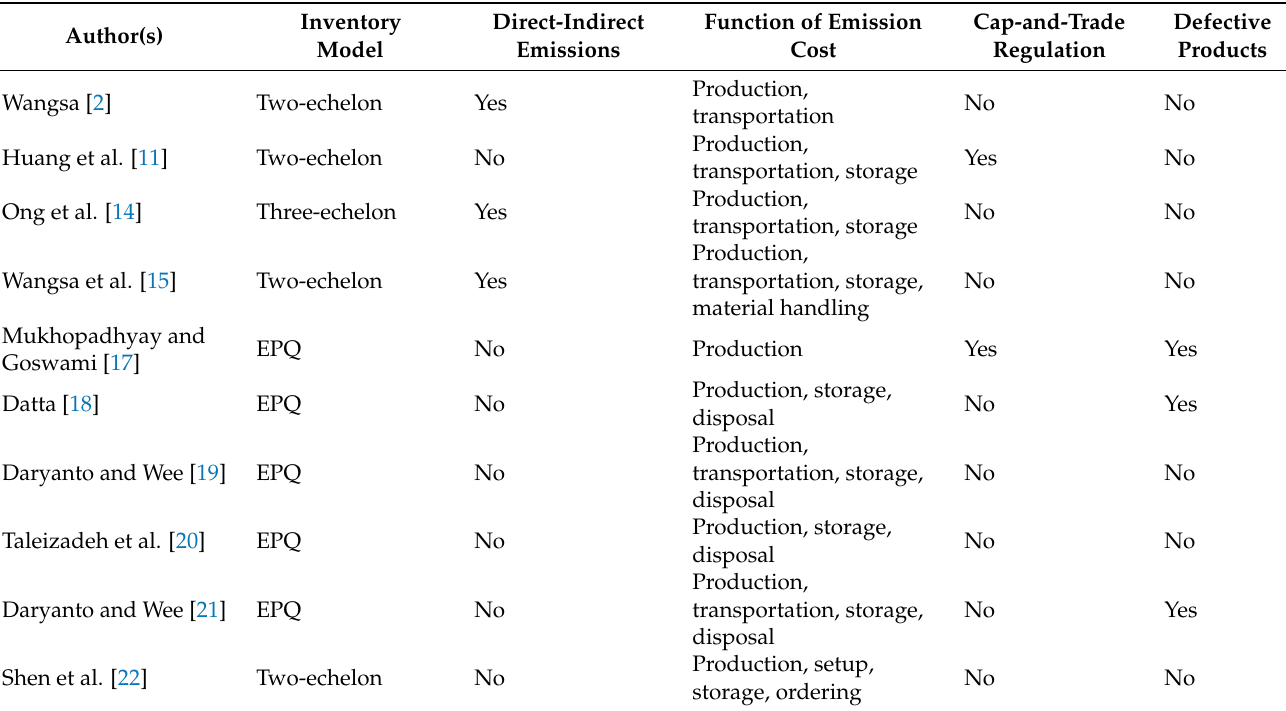
Table 1. Literature